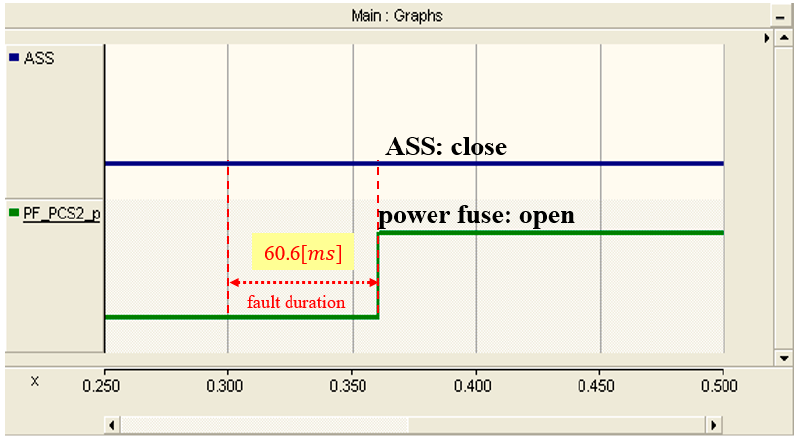
Figure 17 . Protection coordination under the proposed operation algorithm . Figure 17. Protection coordination under the proposed operation Table 2. Comparison of simulation results.